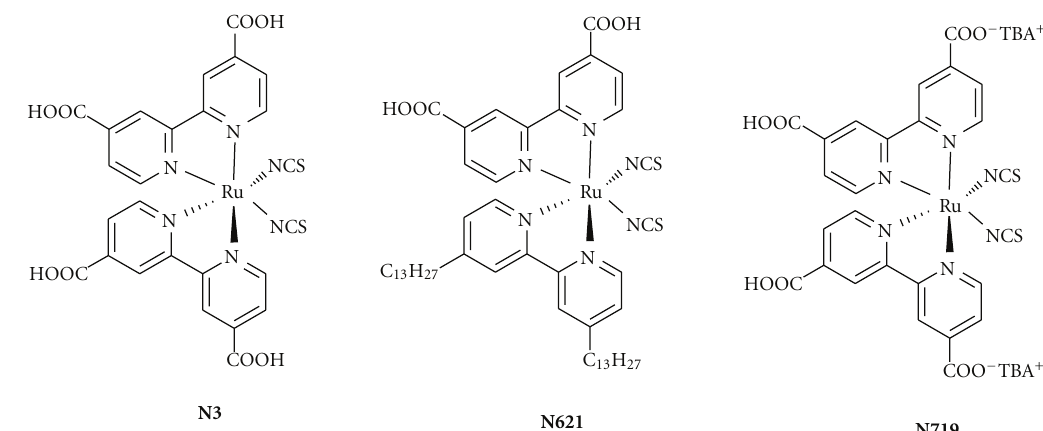
Figure 6: Molecular structures of N3 , N621 , and N719 dyes (taken from [22]).